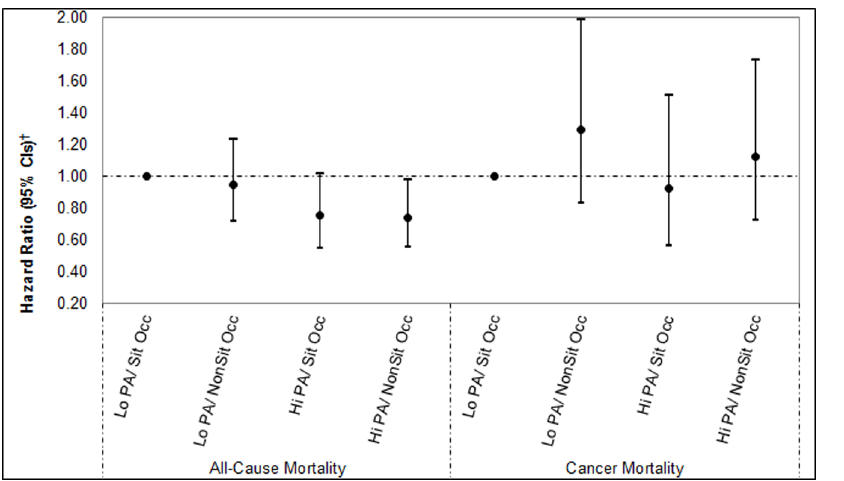
Figure 2. The combined association of main activity at work and non-occupational physical activity in men (N=5620). Lo PA/Sit Occ: Low physical activity/Sitting occupation; Lo PA/NonSit Occ: Low physical activity/standing or walking occupation; Hi PA/Sit Occ: High physical activity/Sitting occupation; High physical activity/standing or walking occupation. { Adjusted for age, self-reported general health, alcohol drinking frequency, cigarette smoking, prevalent cardiovascular disease at baseline (angina/stroke/ischaemic heart disease), prevalent cancer at baseline, occupational social class and age finished education.